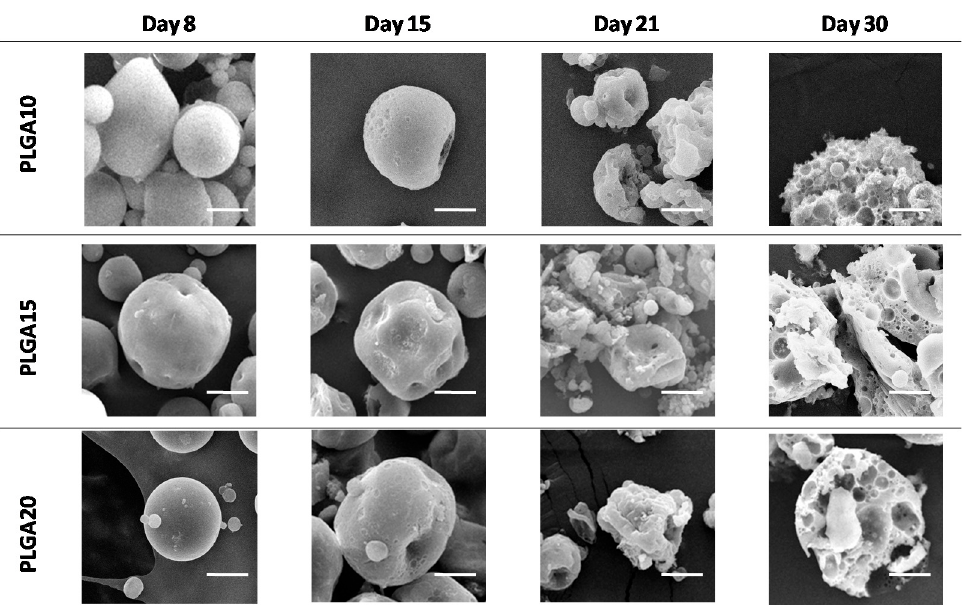
Figure 1. SEM micrographs of degrading MS. Progressive loss of structural integrity in time has been evidenced. The bar is 10 m.